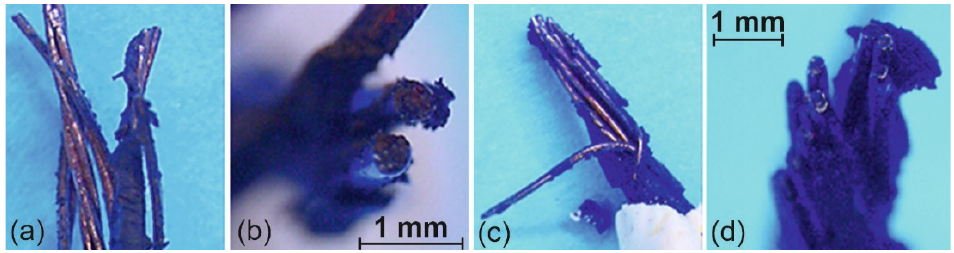
Figure 14. View of selected steel wires: ( a , b )—sample 3; ( c , d )—sample